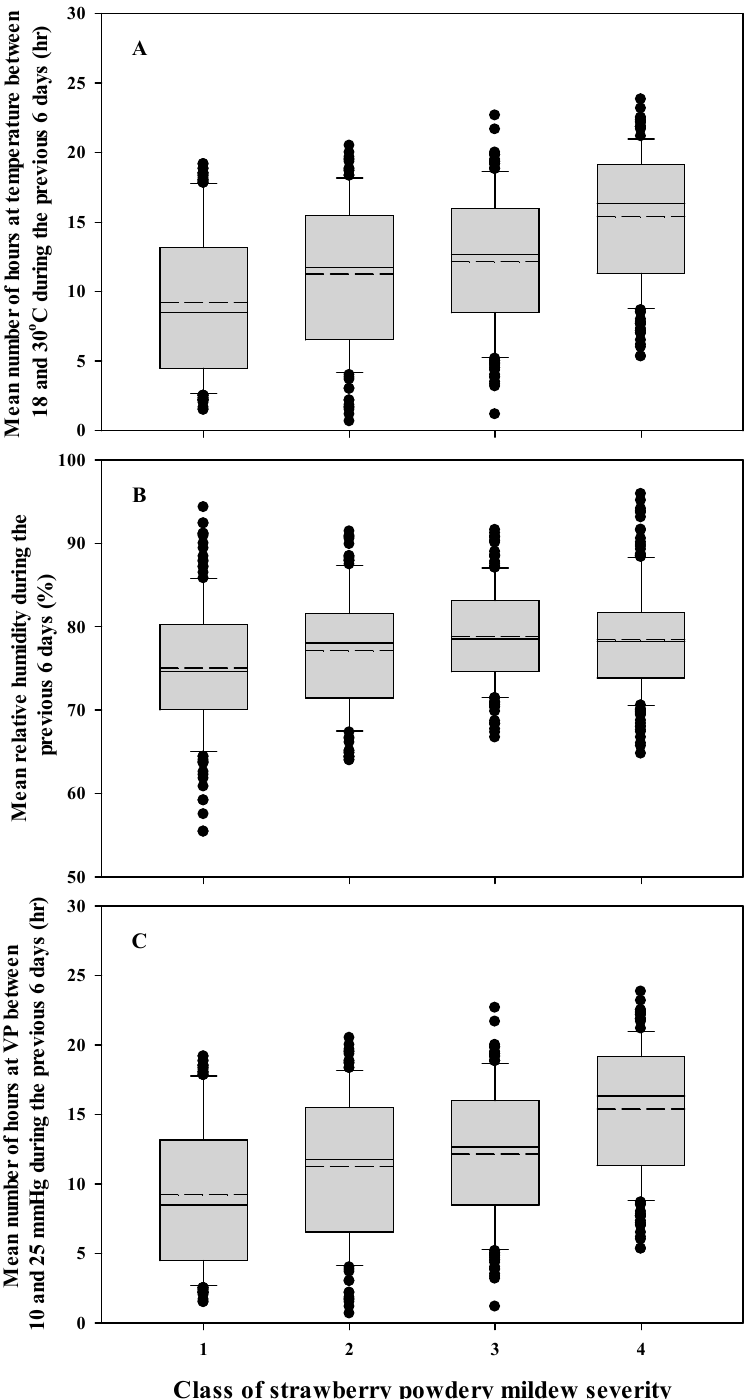
Figure 3. Distribution of the number of hours at temperature between 18 and 30 °C during the previous six days ( A ), mean relative humidity (%) during the previous six days ( B ) and mean number of hours at VP between 10 and 25 mmHg during the previous six days ( C ) for the four classes of strawberry powdery mildew. Classes are 1: PLAD = 0; 2: PLAD > 0 and ≤ 5%; 3: >5% and ≤ 15%; and 4: PLAD > 15%, where PLAD is the proportion of leaf area diseased. For each boxplot, from bottom to top, except for the thicker line and whisker caps, each horizontal line marks 25%, 50%, and 75% of data points, respectively. The dashed horizontal line is the mean value and black circles are outliers.